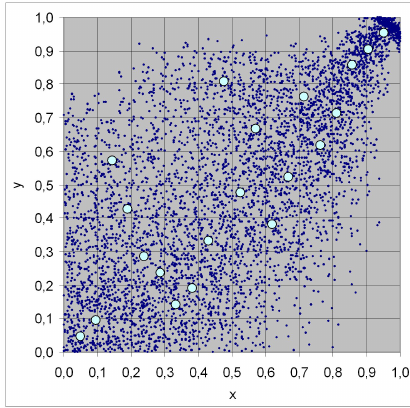
Figure 17: "Worst case" negative binomial copula, a = b = 5